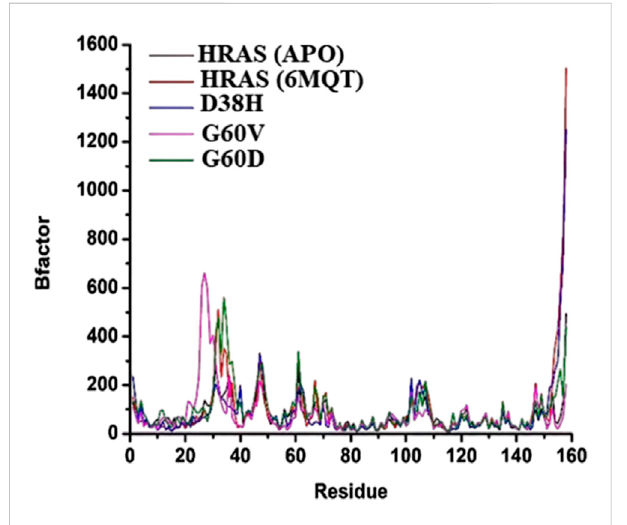
FIGURE 10 The beta (B)-factor, also known as the temperature factor, measures the thermal stability and fl exibility of a protein.